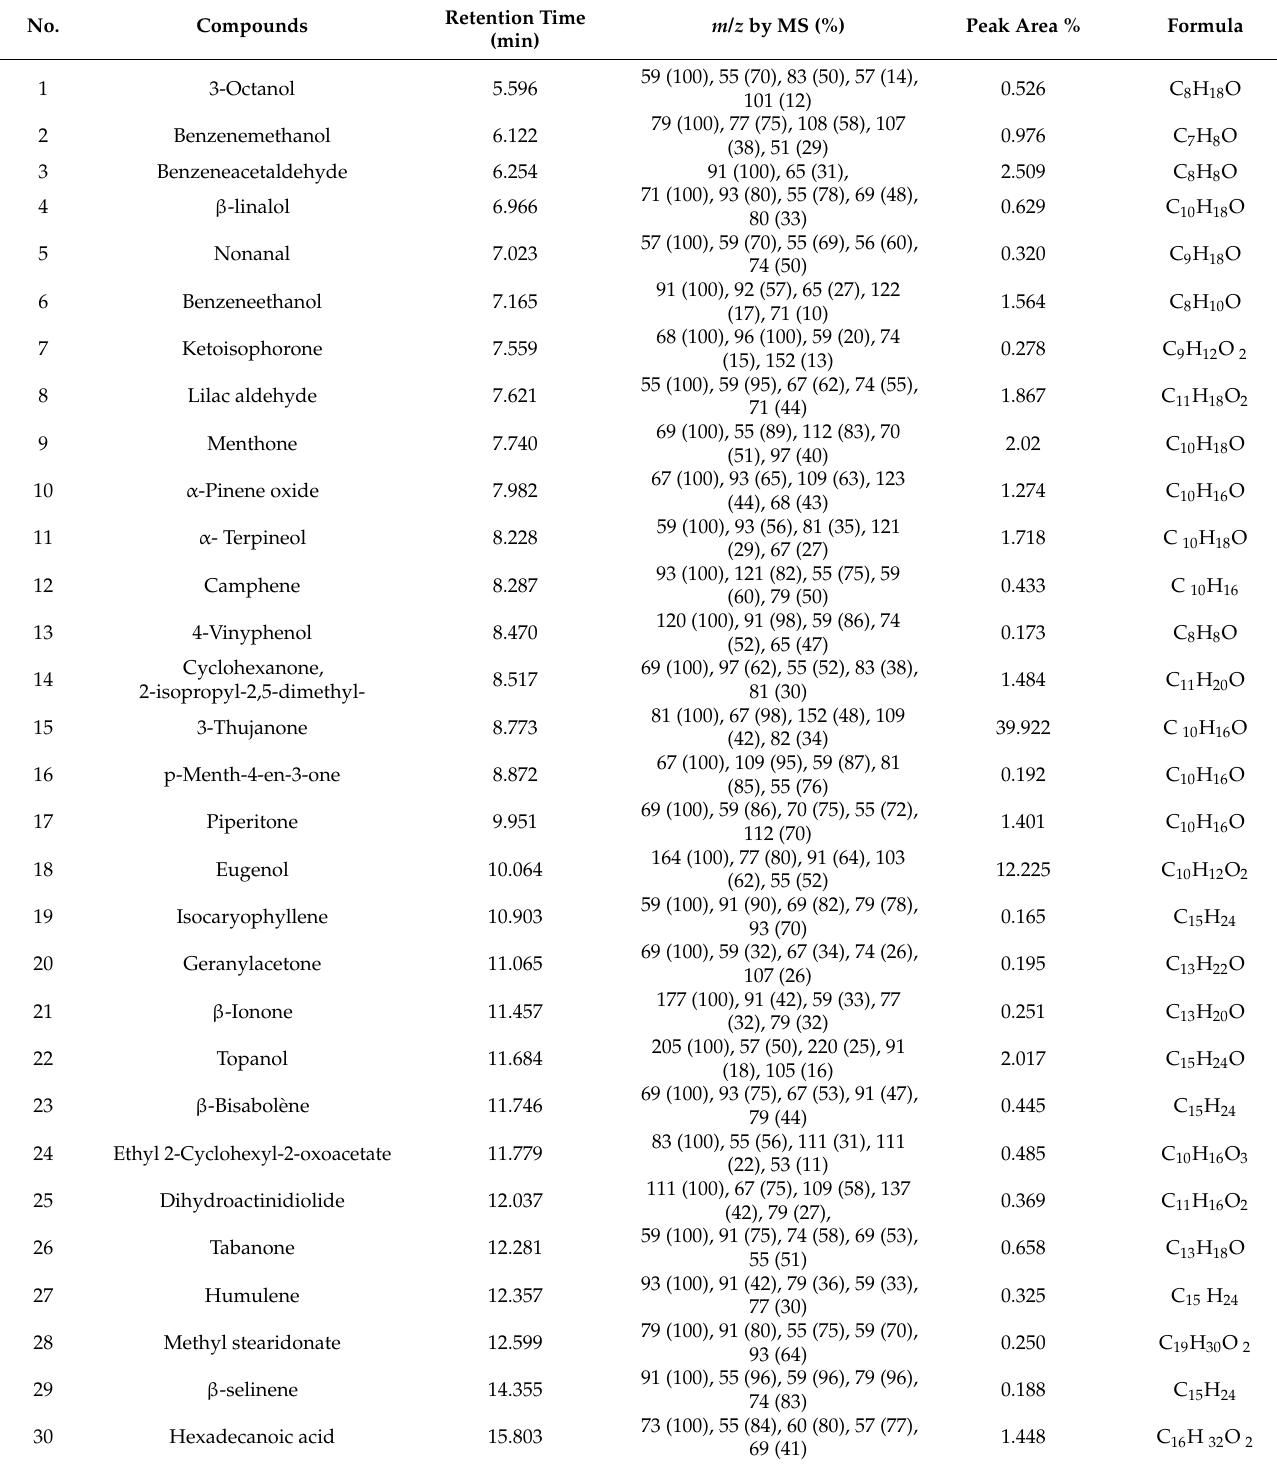
Table 2. Chemical composition of essential oil of M. vulgare